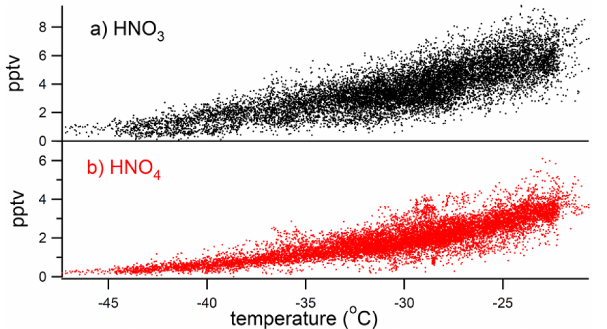
Figure 3. (a) Nitric acid (HNO 3 ) and (b) peroxynitric acid (HO 2 NO 2 ) vs. ambient temperature; 10min averages of measure- ments made from 24 May to 18 September 2007.